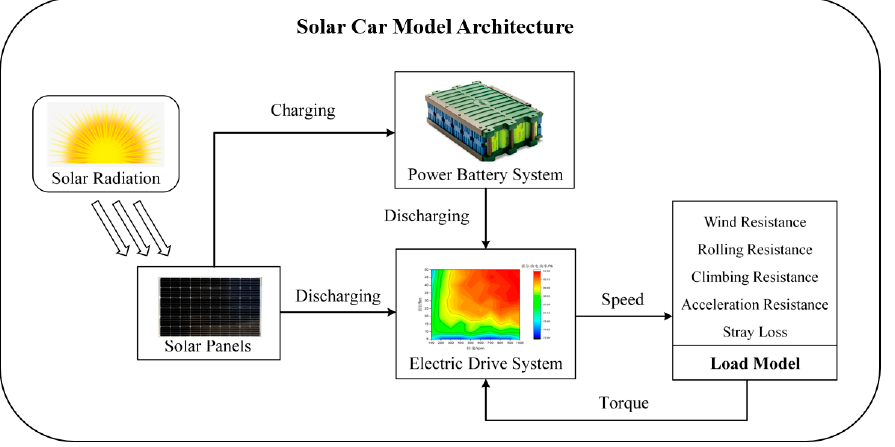
Figure 3. Overall modeling framework diagram.